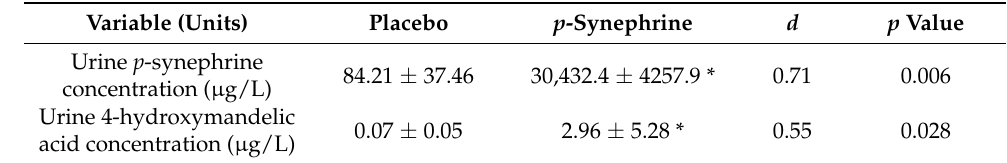
Table 4. Urine p -synephrine and 4-hydroxymandelic acid concentrations after the ingestion of 3 mg/kg of p -synephrine or a